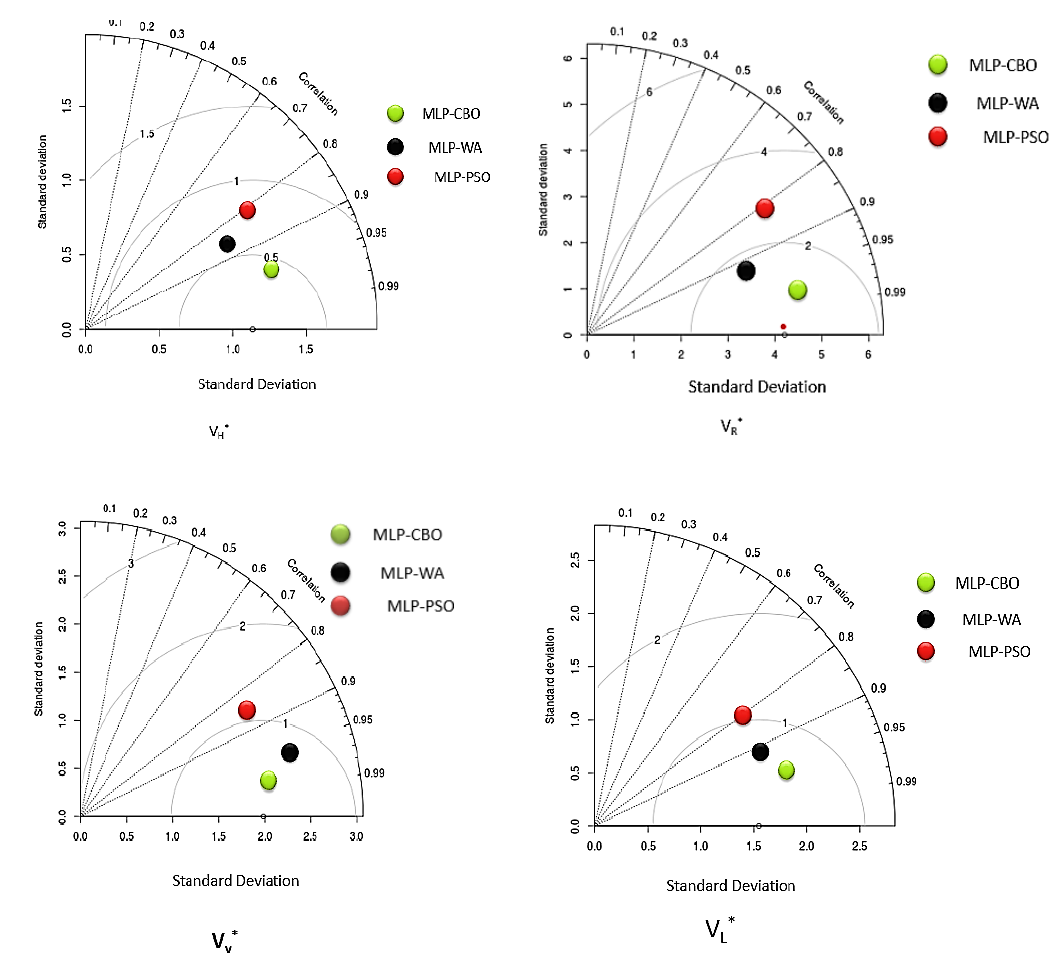
Figure 8. Taylor diagram for soft computing models. Based on correlation, RMSE, and standard deviation for V R *, V V *, V L *, and V H *.